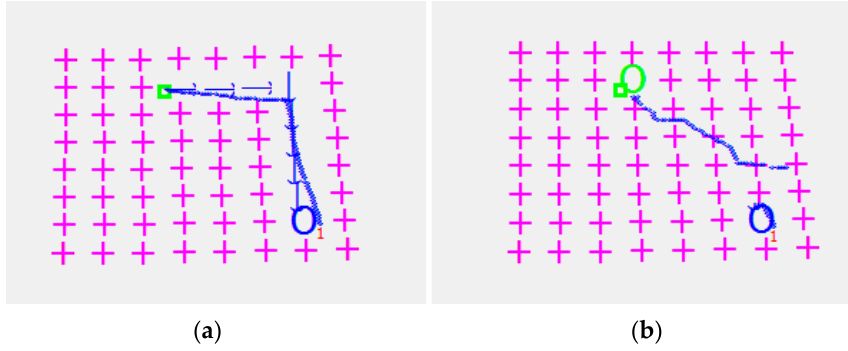
Figure 16. Object displacement algorithm: horizontal and vertical movements ( a ); diagonal movements ( b ).